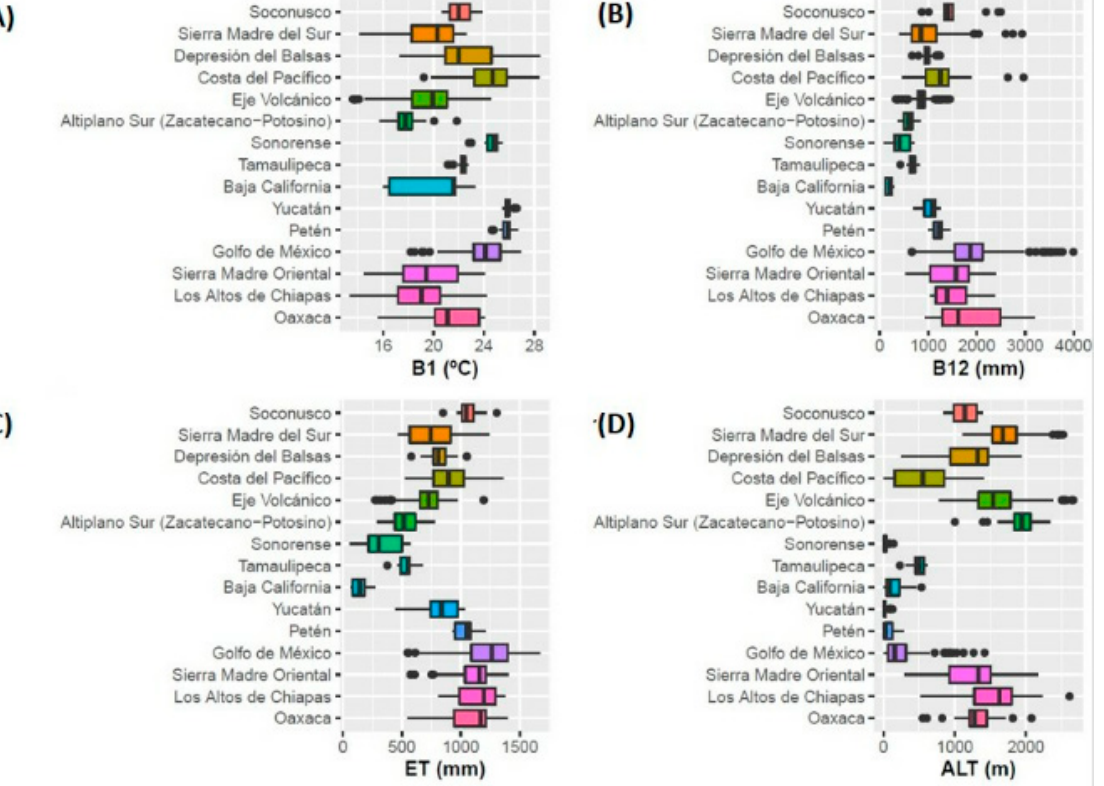
Figure 3. Boxplots of four important variables for the distribution of wild tomato species in Mexico. ( A ) Annual mean temperature (B1, °C), ( B ) annual precipitation (B12, mm), ( C ) annual evapotranspiration (ET, mm), and ( D ) digital elevation model (ALT, m).